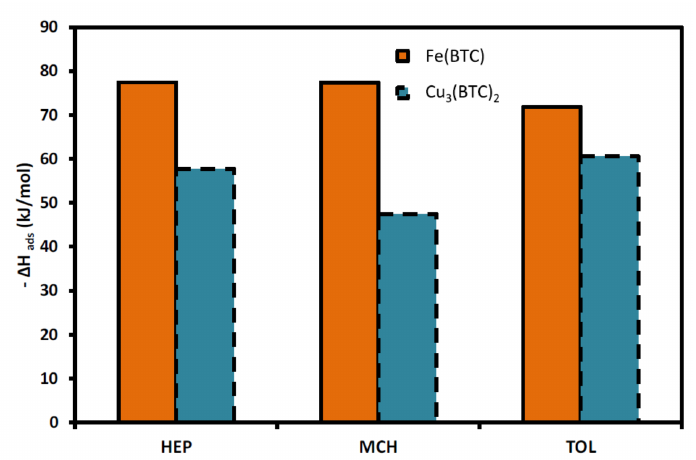
Figure 6. Enthalpy of adsorption for Fe-BTC and HKUST-1 for the three adsorbates. Reprinted with permission from [58]. Copyright (2015)